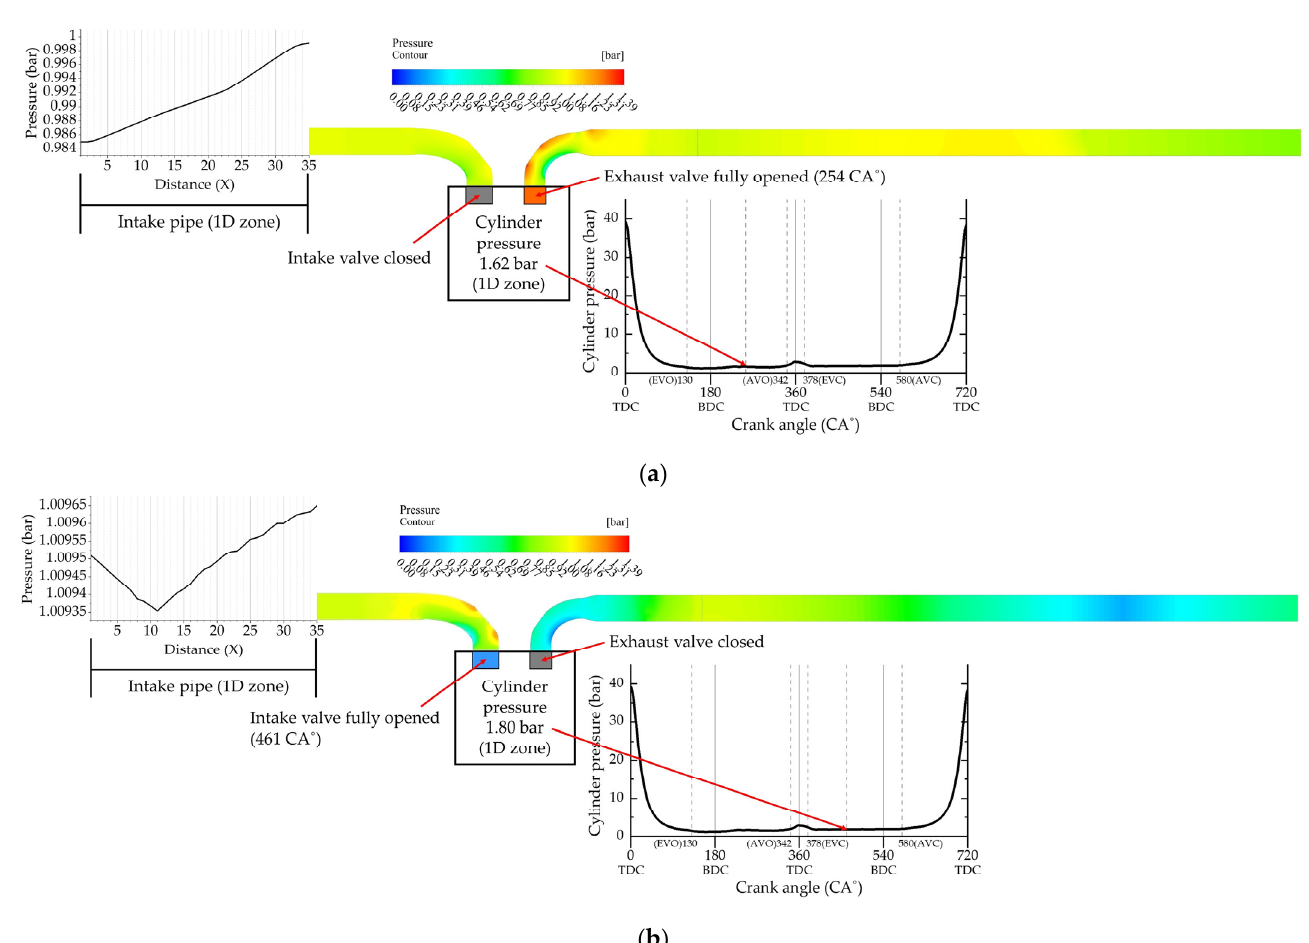
Figure 2. The pressure results of numerical analysis using the 1D–3D approach for the entire intake/exhaust system: ( a ) when the exhaust valve was fully opened (254 CA ◦ ); ( b ) when the intake valve was fully opened (461 CA ◦